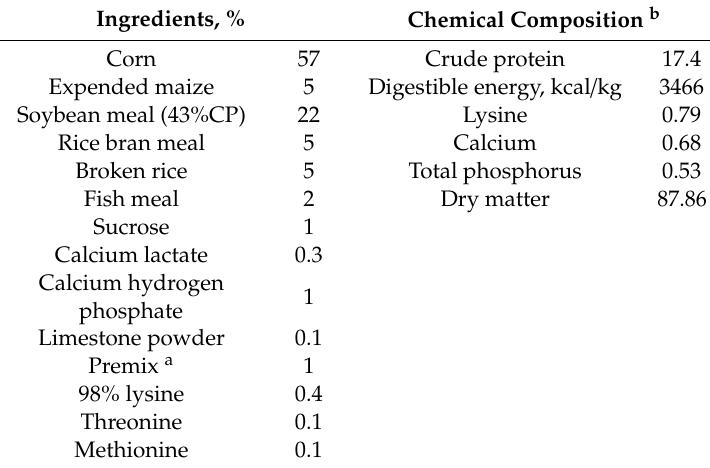
Table 1. Composition of Basal Diets (as-fed